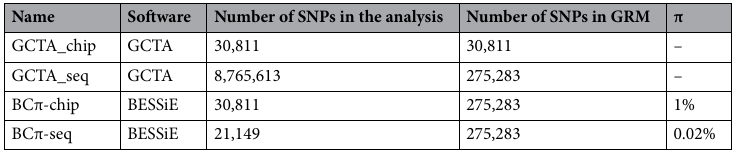
Table 1. Summary of GWAS analyses used to detect QTLs associated with spontaneous maleness in XX-rainbow trout. π is the proportion of SNPs with a non-zero-effect included at each cycle k of the MCMC algorithm. GRM genomic relationship